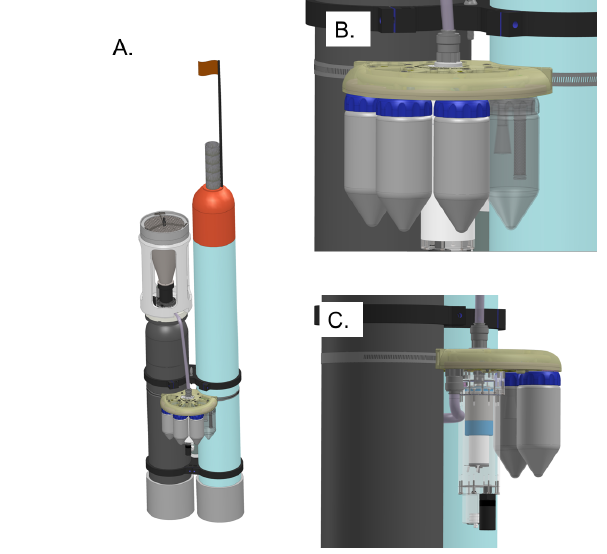
Figure Appendix A4. CFE-Cal configuration. (a) The CFE-OSR is on the left and the SOLO2 float is shown on the right. The funnel at the top of the CFE-OSR is covered by hexagonal baffling with 1cm openings. The funnel is 15.4cm in diameter. At the base of the fun- nel is a 2.54cm diameter glass stage. From here, samples are flushed through the grey tubing pictured above into the sampling unit. (b) Close-up of attached sampling system. Far right bottle translucent to show details of bottle inlet and outlet. (c) Side view of sampler with one of the bottles removed to show how motor housing is at- tached to the sampler. The planetary gear motor is located inside the clear acrylic housing.